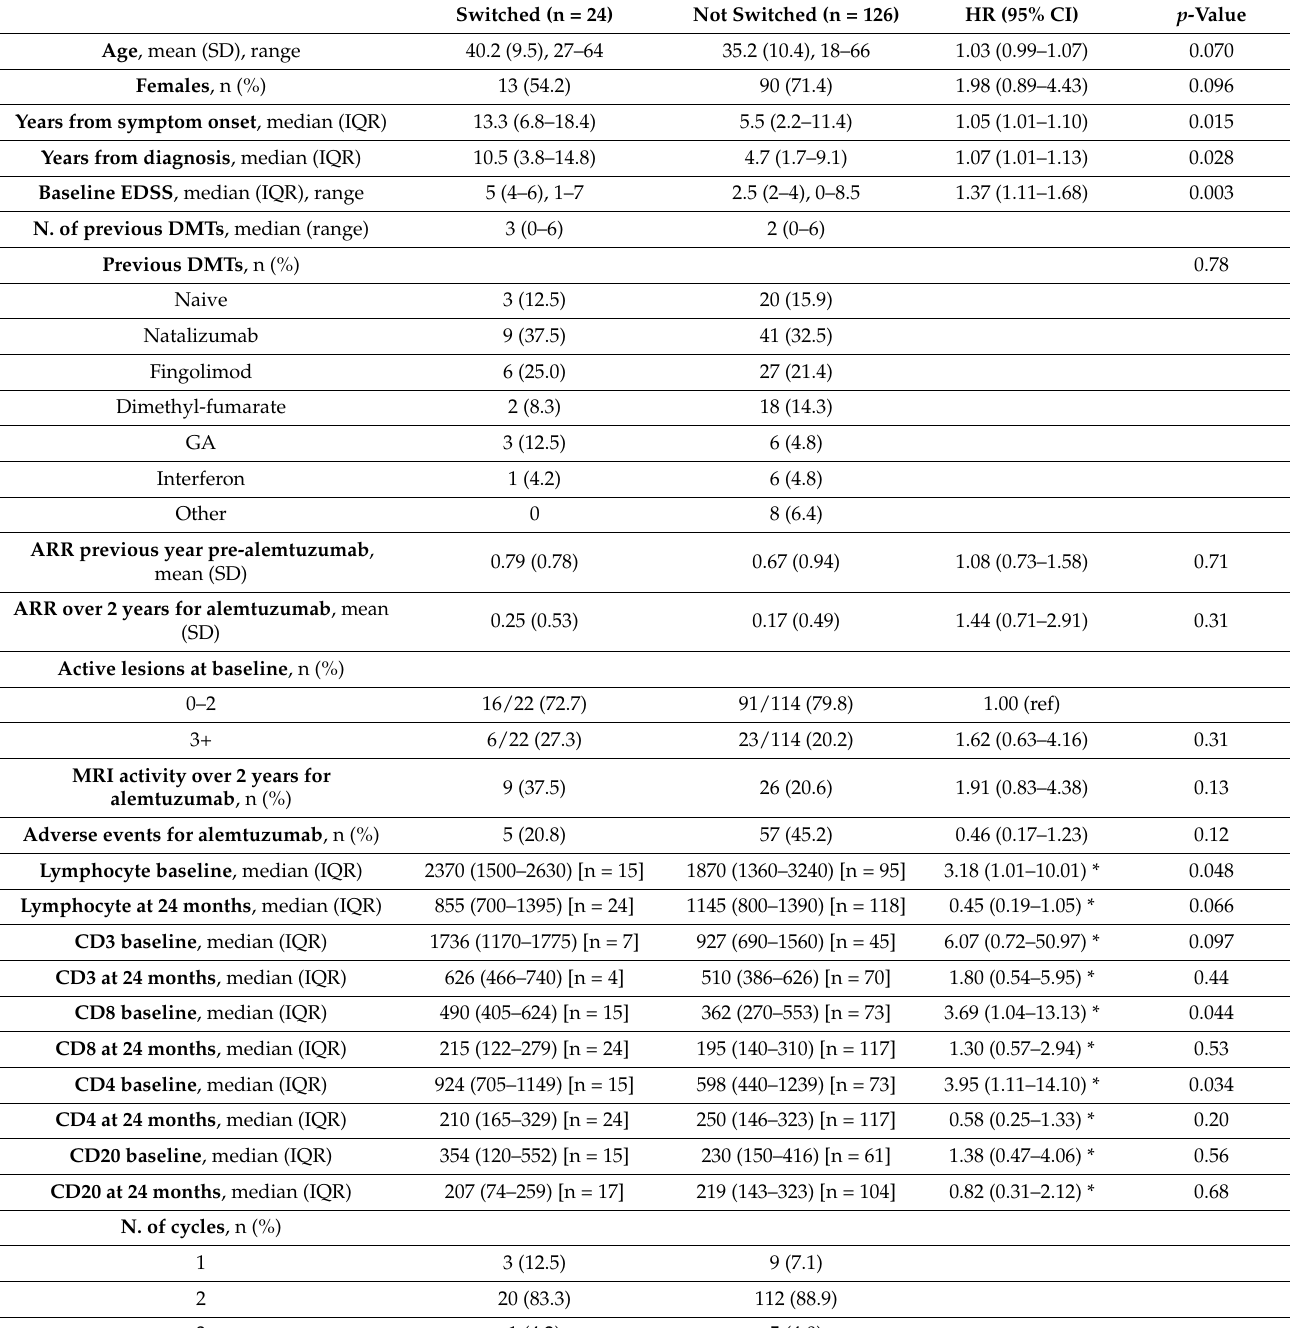
Table 3. Demographic and clinical characteristics associated with time to other treatment switch after